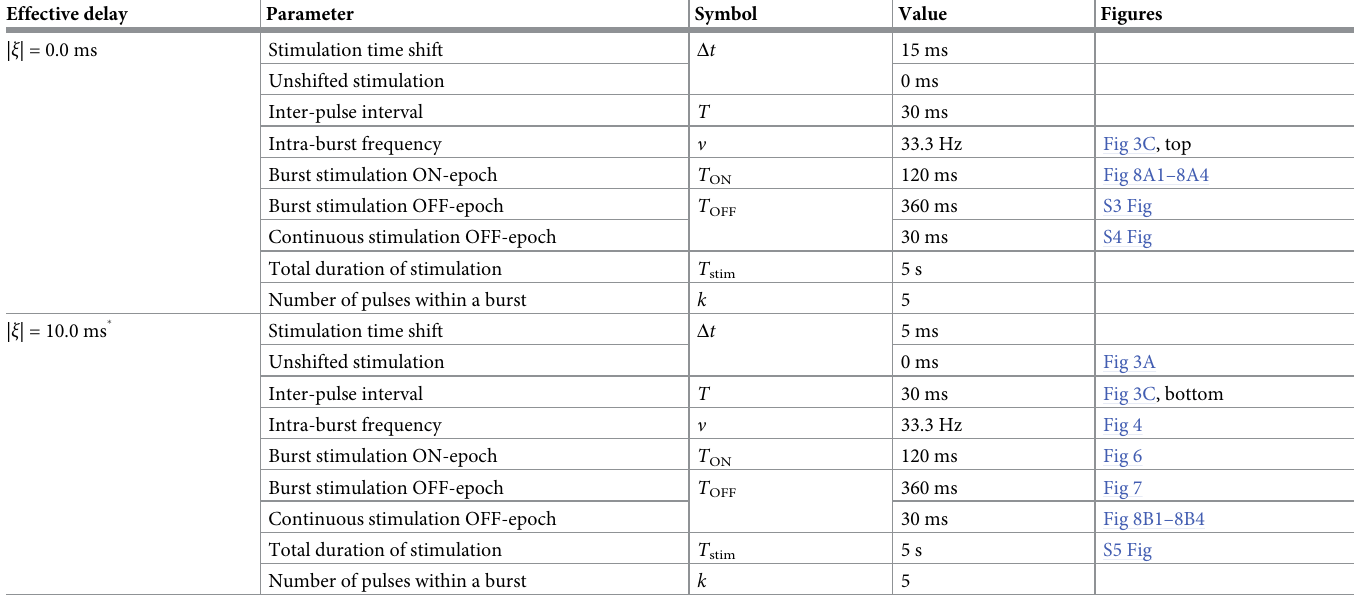
Table 3. Summary of the stimulation model